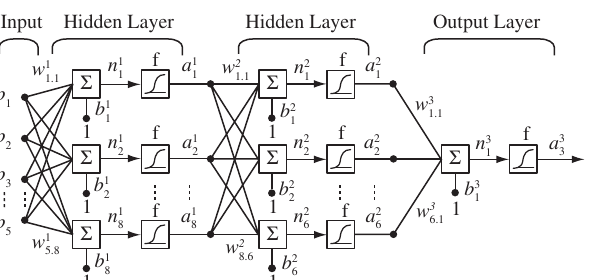
Figure 8. Scattering graph: comparison between observed and predicted